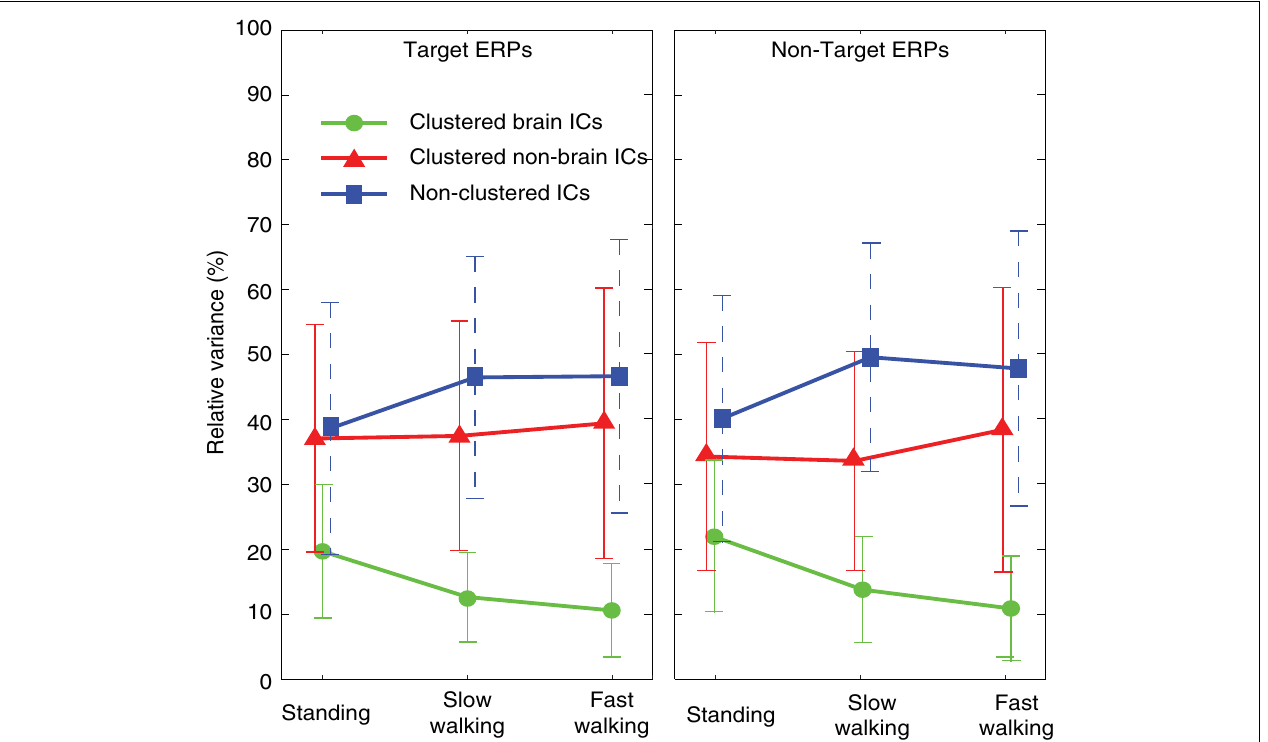
grand-average ERPs summing projections of all three IC classes. Left and right panels show results for ERPs time locked to onsets of target (left column) and non-target stimuli (right column) in the three movement conditions (standing, slow walking, fast